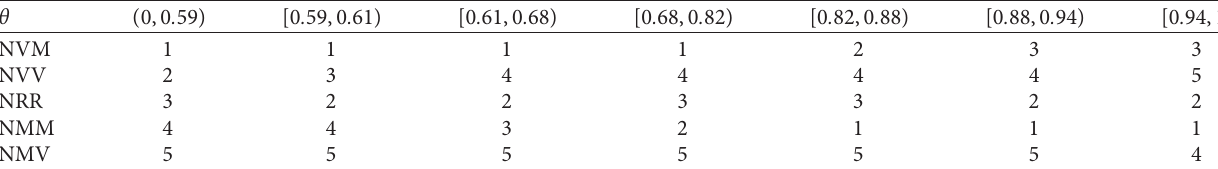
Table 4: Rank ordering with respect to channel 1 efficiency given Ω �